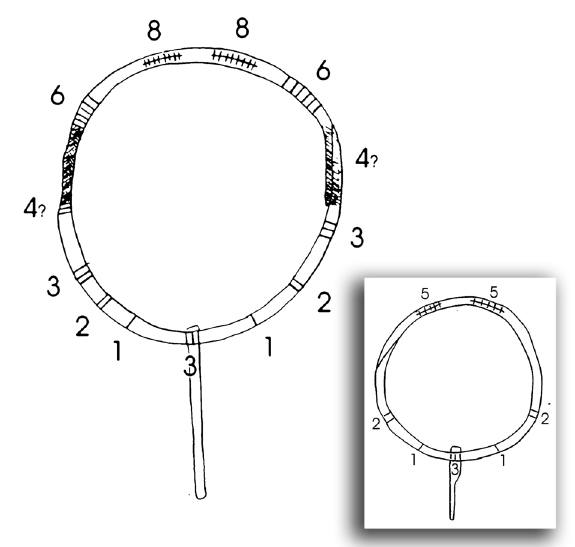
Figure 7. The sequence of incised marks on the back of the drum frames. The main image is PfFm-01:1750 and the inset image is PfFm-01:1749 as it would appear with the opened ends overlapping and scarfed